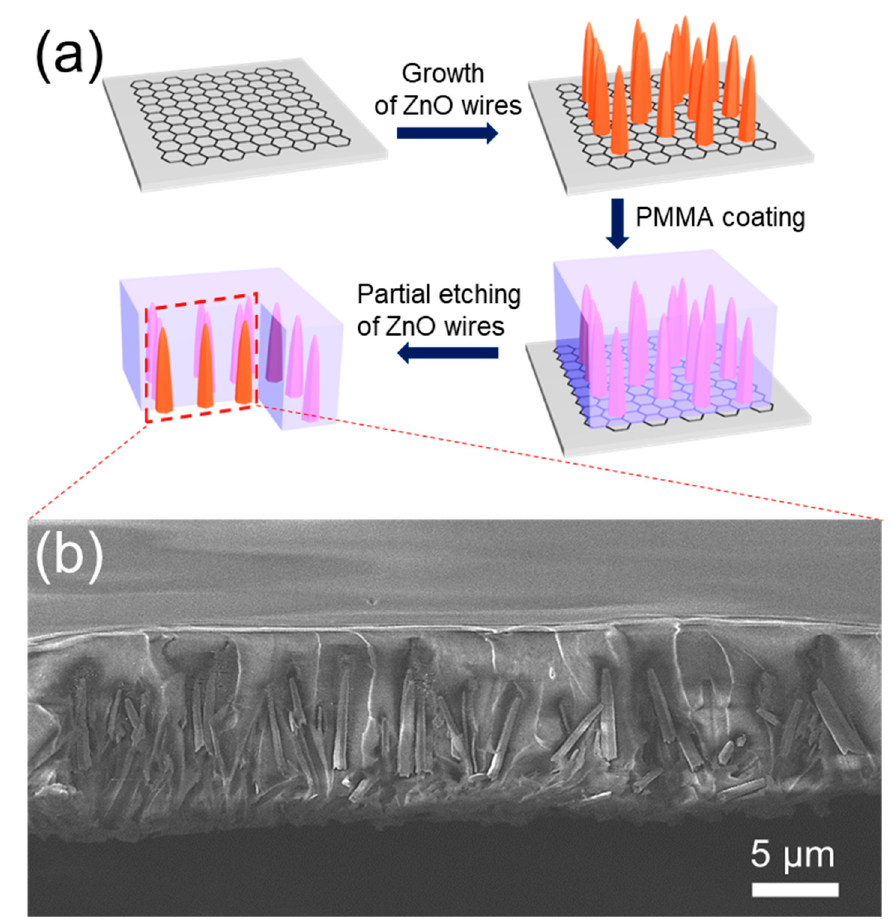
Figure 3. ( a ) A schematic of the process to separate ZnO wires from CVD-graphene by PMMA coating and partial wet etching processes. ( b ) Tilted-view SEM image of ZnO wires embedded in PMMA after separation from graphene.